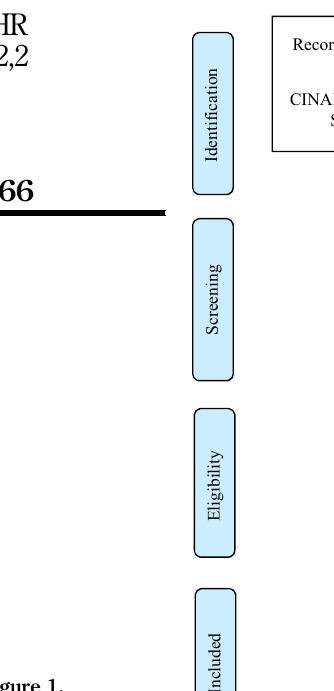
Figure 1. Prisma flow